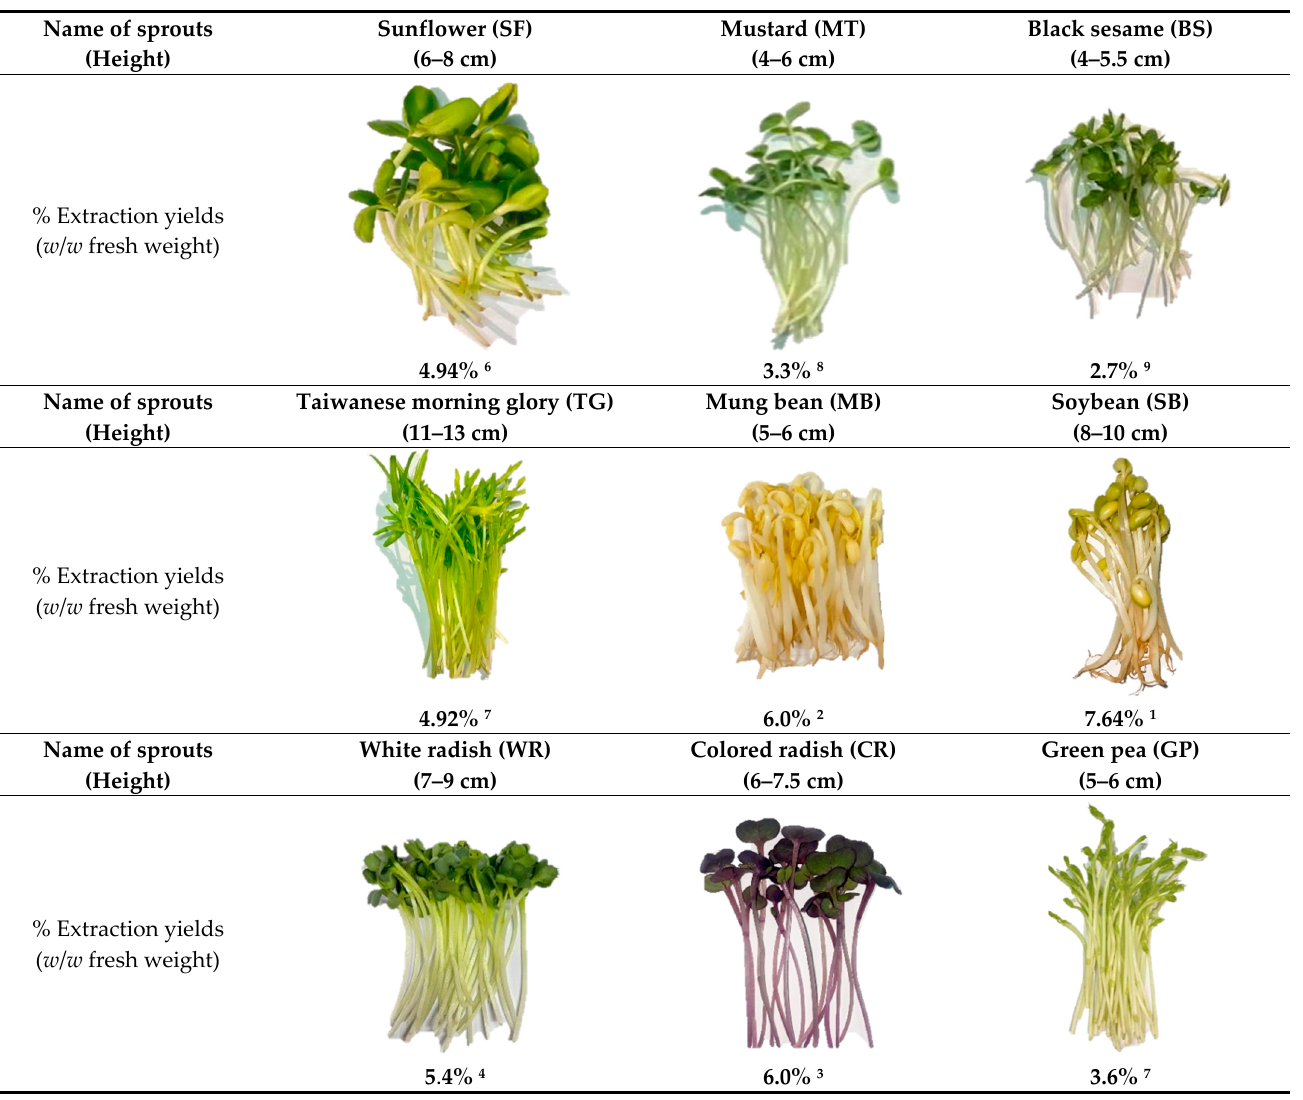
Figure 1. Sprouts at cultivated ages (4–7 days) and different yields. Superscript numbers indicate the rank from high (1) to low (9) % extraction yields.